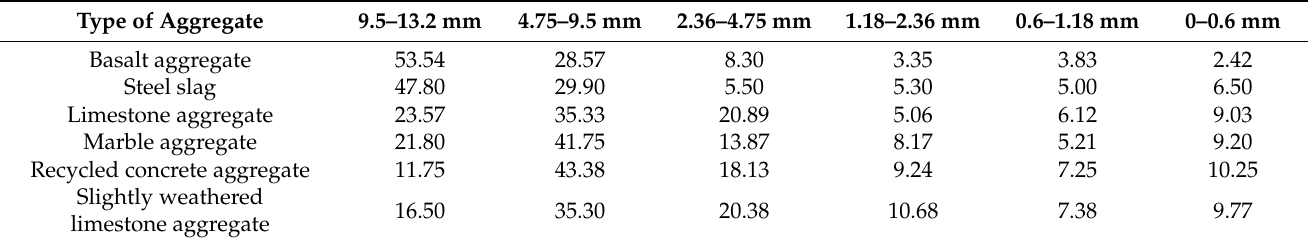
Table 2. Aggregate particle distribution after static ACVTs for various types of